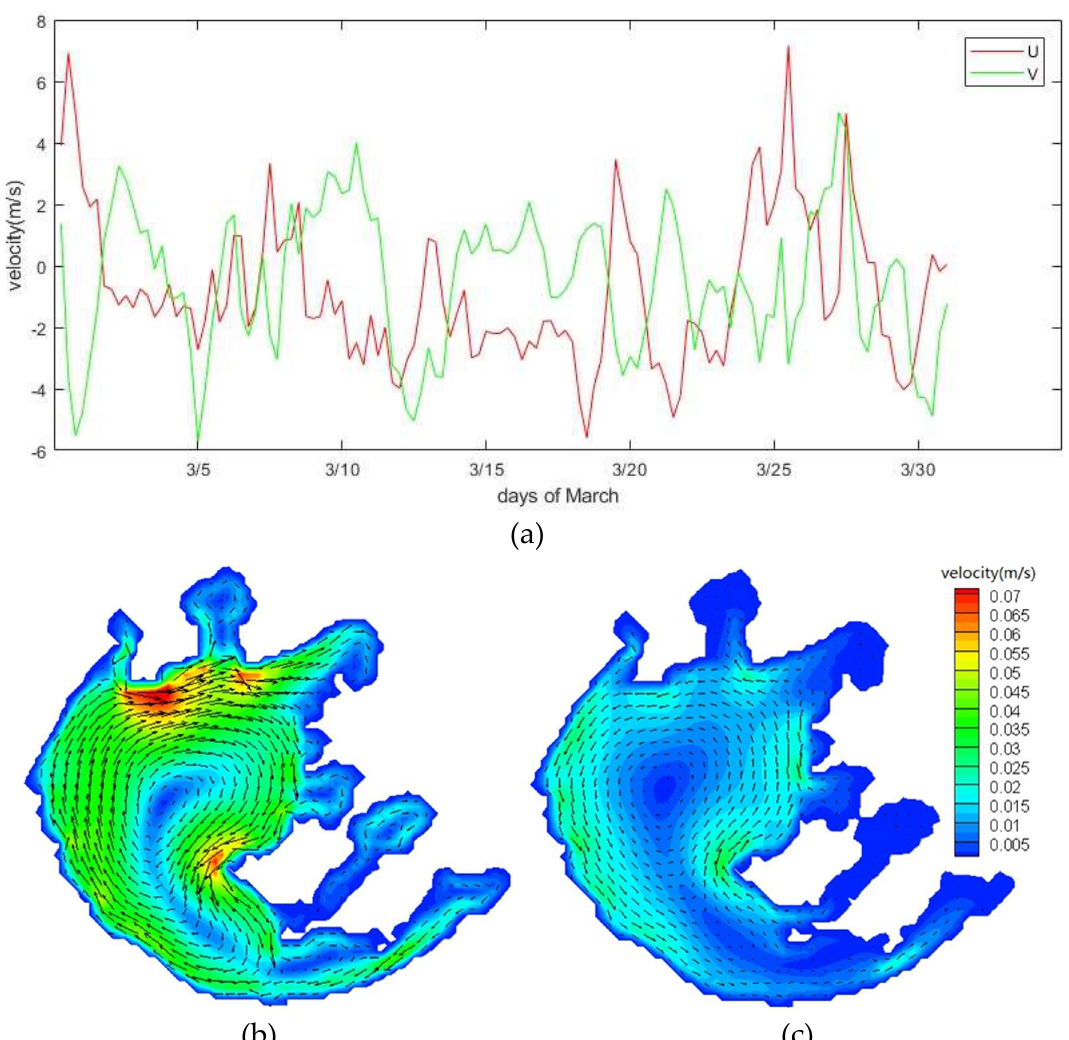
Figure 7. ( a ) Average wind velocity components above Lake Taihu in March and ( b ) water velocity Figure 7. (a) Average wind velocity components above Lake Taihu in March and (b) water velocity contour and vector after 5 days and ( c ) 8 contour and vector after 5 days and (c) 8 days.